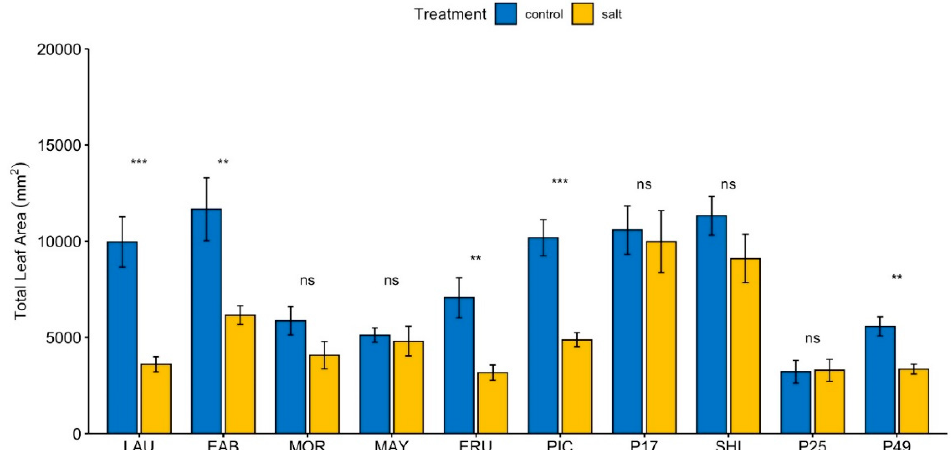
Figure 1. Effect of salinity on lettuce leaf area. Total leaf area was calculated using the PlantScreen phenotyping system. Values are means of two independent experiments, each with at least four biological replicates. Bars represent standard errors; asterisks indicate statistical significance as calculated by the t -test. * ( p ≤ 0.05), ** ( p ≤ 0.01), *** ( p ≤ 0.001), **** ( p ≤ 0.0001), ns = not significant ( p > 0.05).